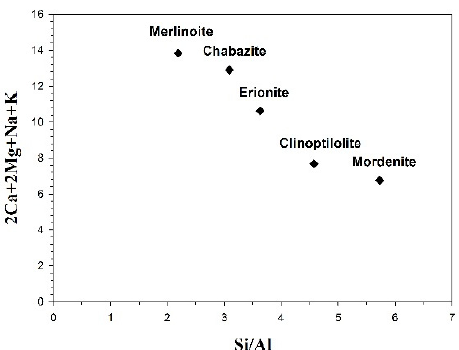
Figure 4. Relationship between the Si/Al ratio and IA and IIA cation content in zeolite compositions.